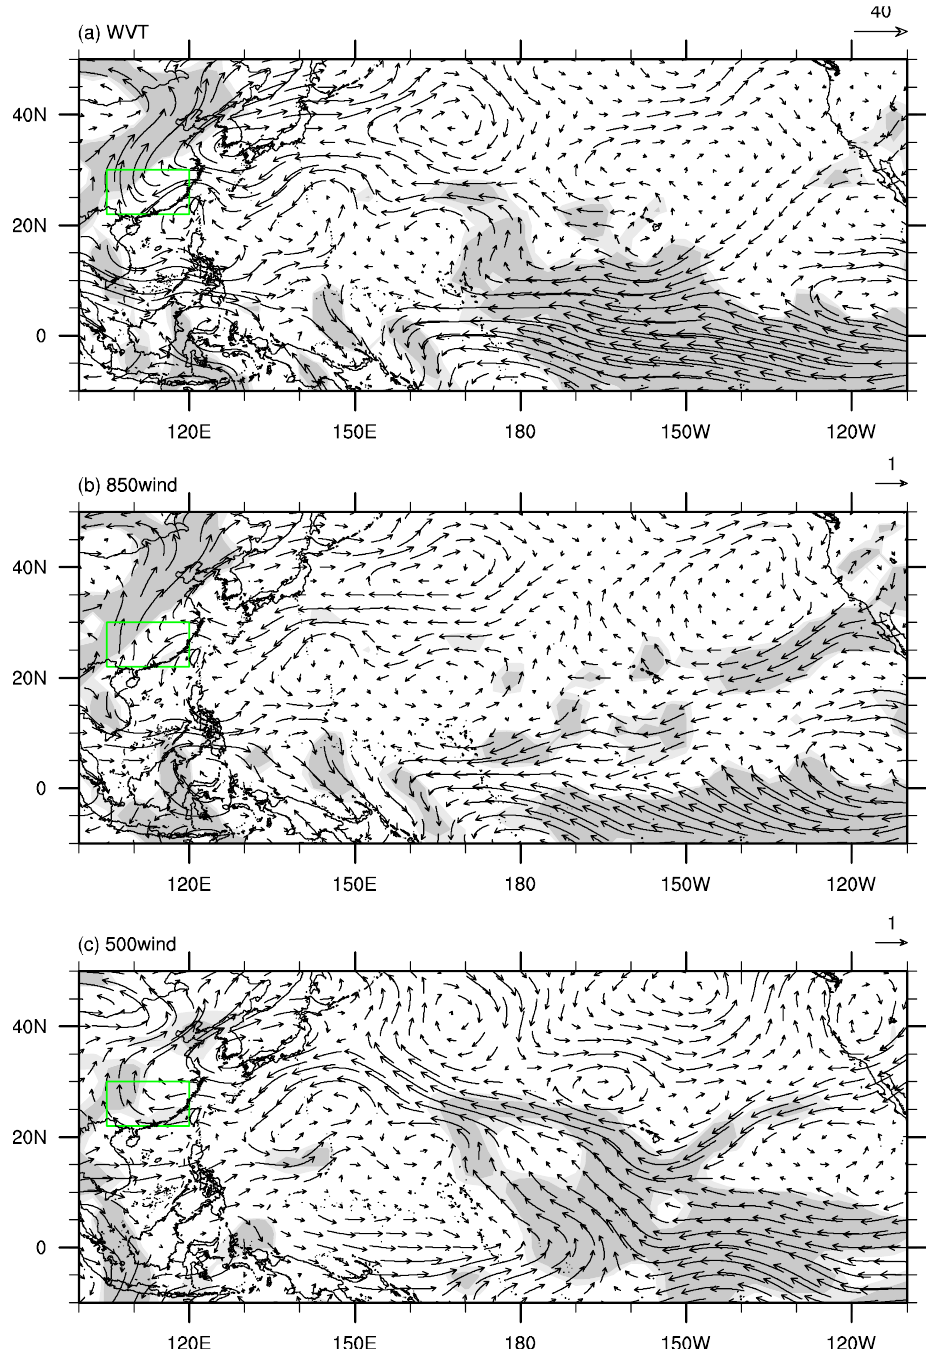
Figure 8. The differences in the summer mean ( a ) vertically integrated water vapor transport (vector, unit: kg m − 1 s − 1 ), ( b ) 850–hPa wind (vector, m s − 1 ) and ( c ) 500–hPa wind (vector, m s − 1 ) between P2 and P1 (P2 minus P1). Light (dark) shadings denote where the anomalies are significant at the 90% (95%) confidence level based on Student’s t -test. The green rectangle in ( a – c ) refers to the domain of southern China.